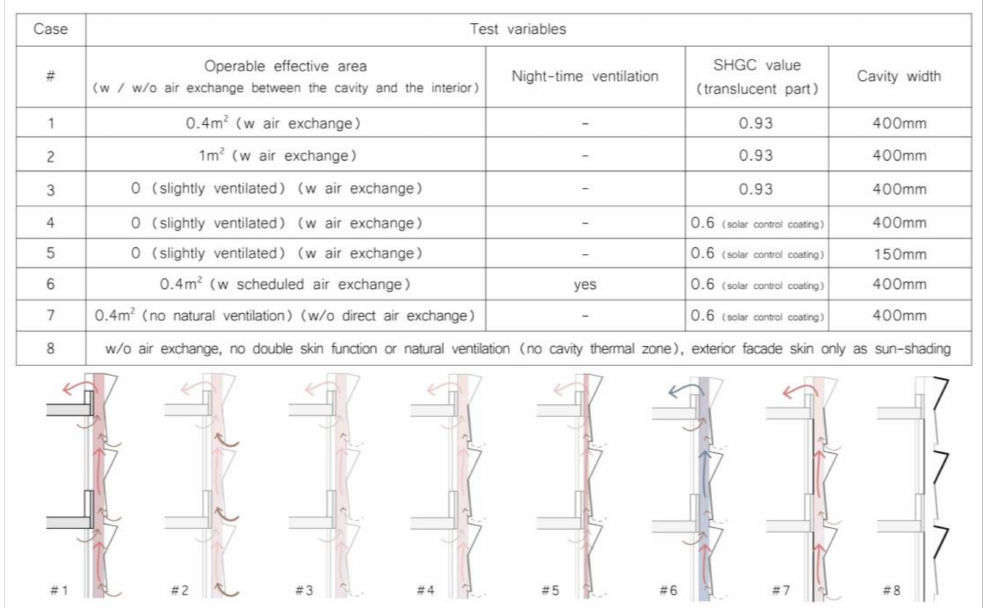
Figure 20. Overview of the case studies and test parameters for the EUI calculation studies for the cooling